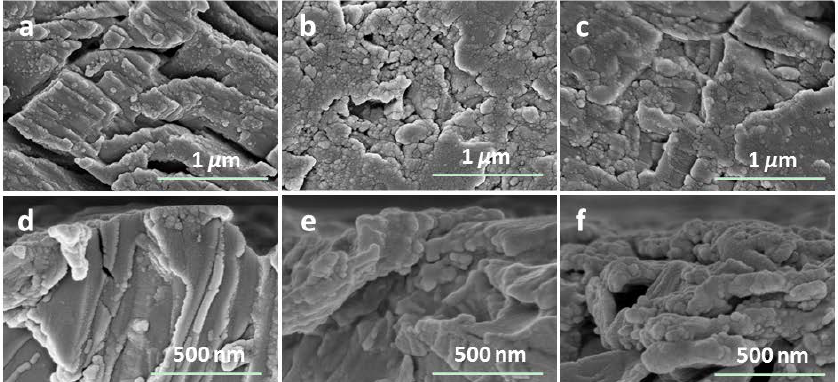
Figure 4. SEM images of the surface and cross section of a blank marble ( a , d ), Hedishi ( b , e ), and Qingshi ( c , f ), respectively.